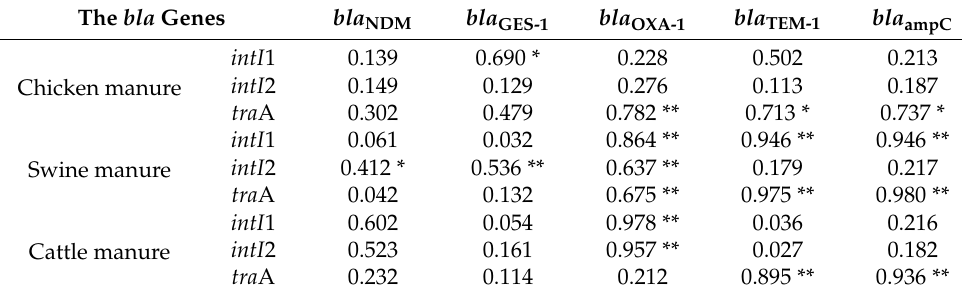
Table 3. The correlation between high-risk bla genes and MGEs. The bla